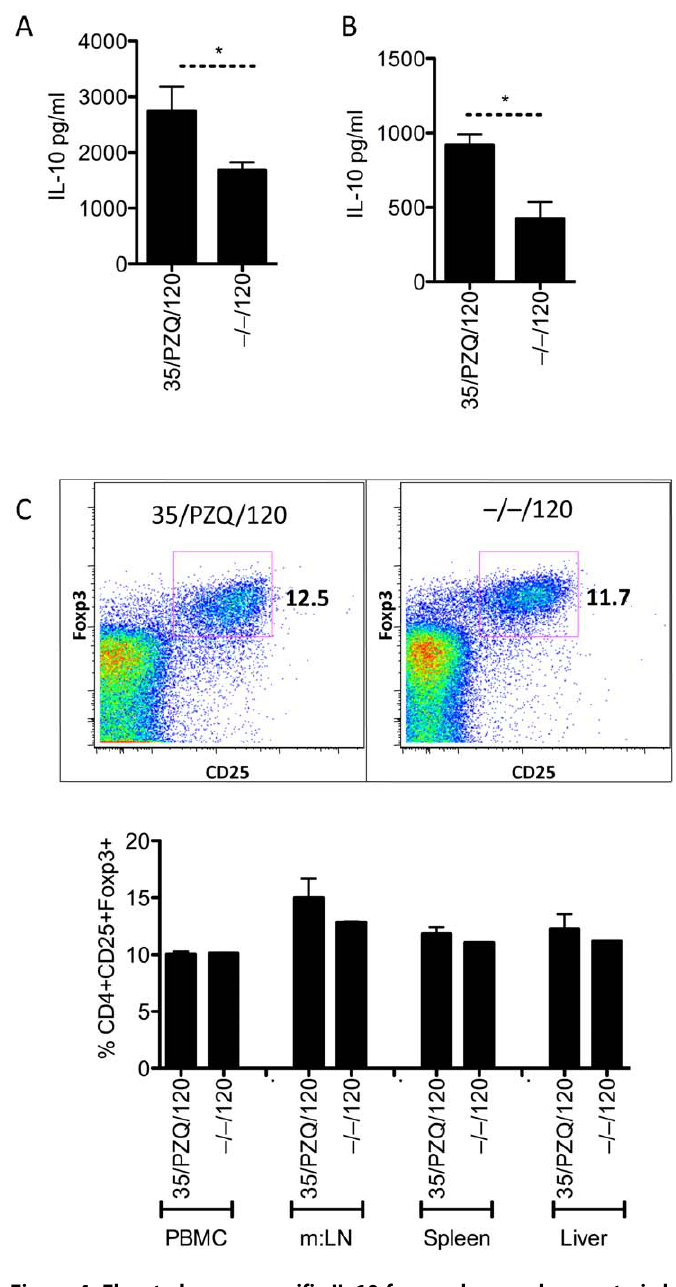
Figure 4. Elevated worm-specific IL-10 from spleen and mesenteric lymphnodes, with unchanged Foxp3 + cells. C57BL/6 mice were infected as in Figure 2, with cells recovered at necropsy. Data shown are mean 6 SEM from one of 2 experiments, with 5 mice per group. (A) IL-10 secretions, measured by ELISA, from adult worm antigen re-stimulated splenocytes. (B) IL-10 secretions, measured by ELISA, from adult worm antigen re-stimulated mesenteric lymph node cells. (C) Foxp3 and CD25 stained CD4 + lymphocytes from peripheral blood, mesenteric lymph nodes (m:LN), spleen and liver.